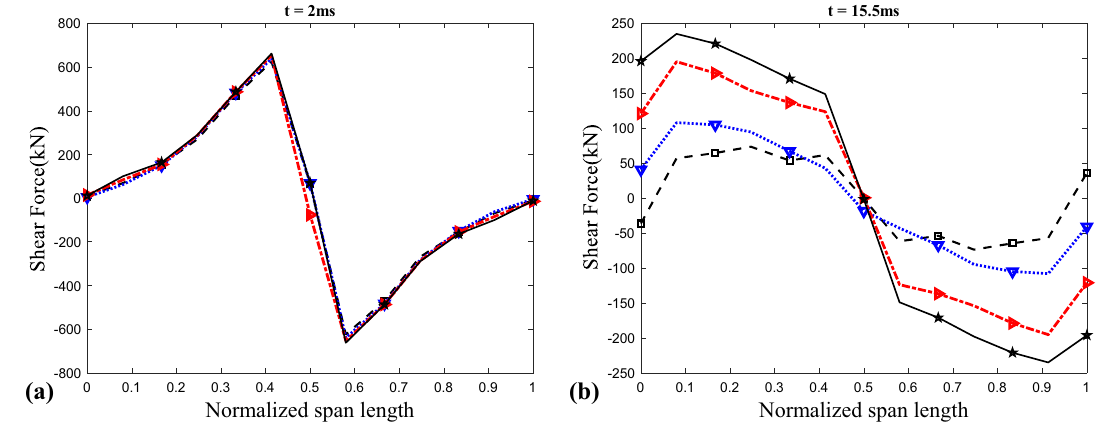
Fig. 13 Shear force distribution along the beam span at different times for